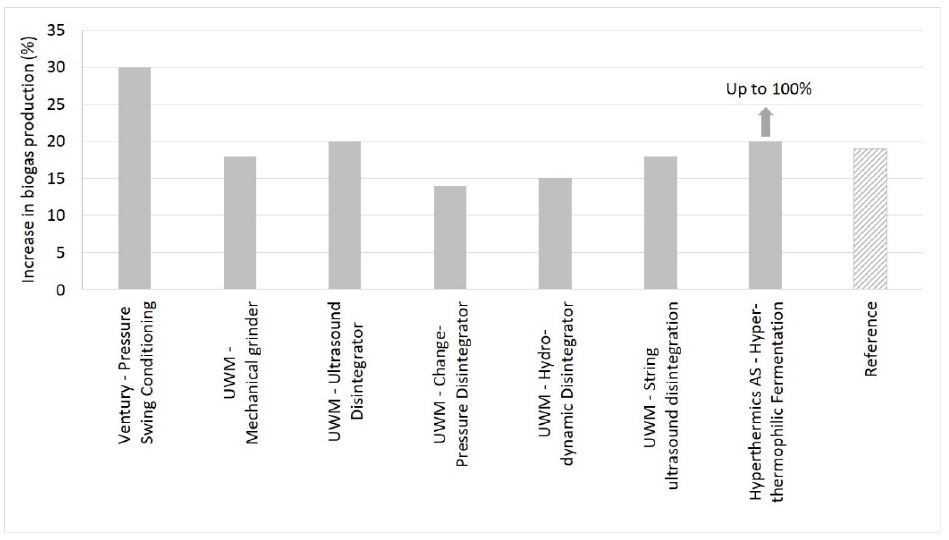
Figure 2. Biogas production increase for pre-treatment technologies.